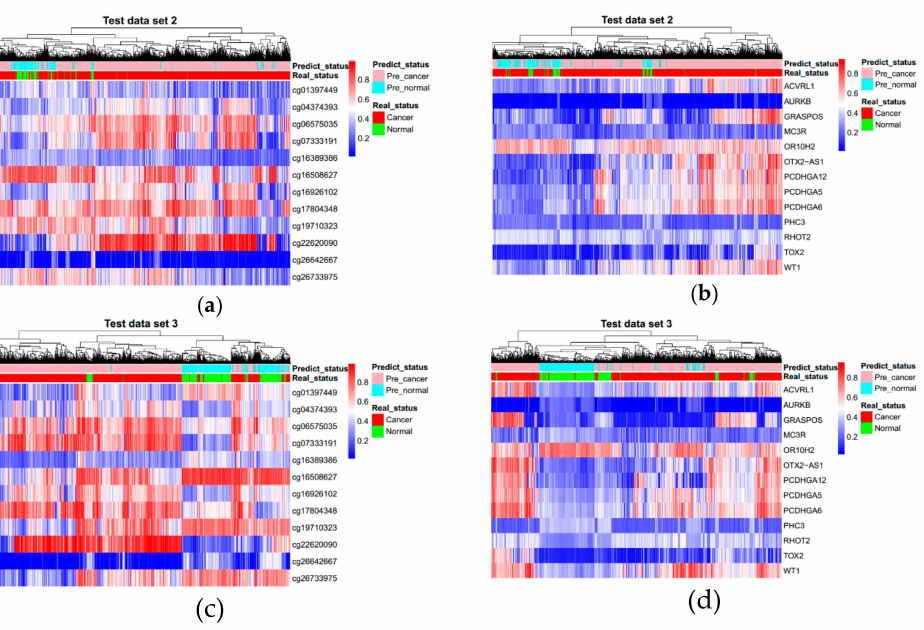
Figure 4. Unsupervised hierarchical clustering of Test data set 2 and Test data set 3. ( a , c ) come from 12 CpG markers and ( b , d ) come from 13 promoter markers. Methylation beta values range from 0 to